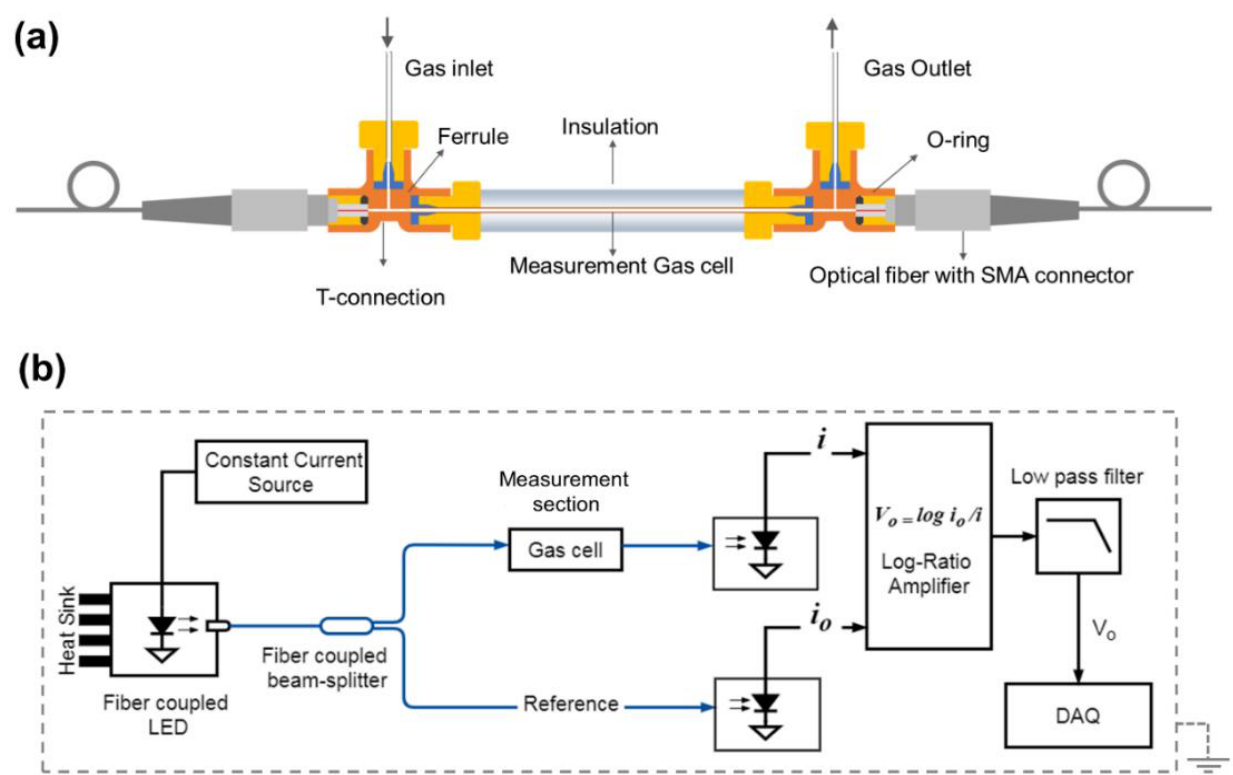
Figure 1. ( a ) Schematic of ultraviolet (UV) absorbance detector: Gas cell with gas and optics connectors. ( b ) Schematic for measuring the absorbance in volts. LabVIEW based data acquisition (DAQ) system was used to record the data.